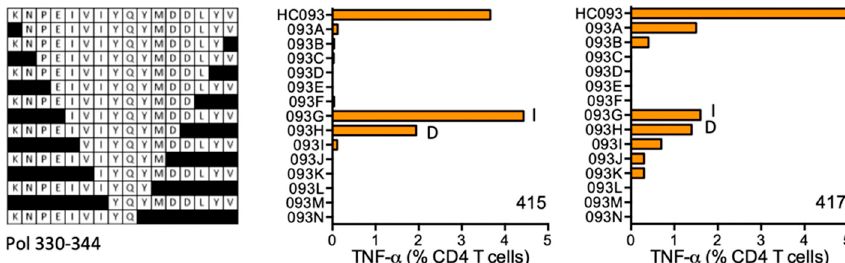
Figure 9. HC093/VID 415 and VID 417—definition of CD4 + T-cell epitopes in HIV-1 protein Pol. HC093-expanded PBMCs from subjects 415 and 417 were tested in ICS against shorter peptides (left) and CD4 + T cells producing TNF- α (orange) were enumerated. Amino acids I and D indicate the stimulatory peptide termini.